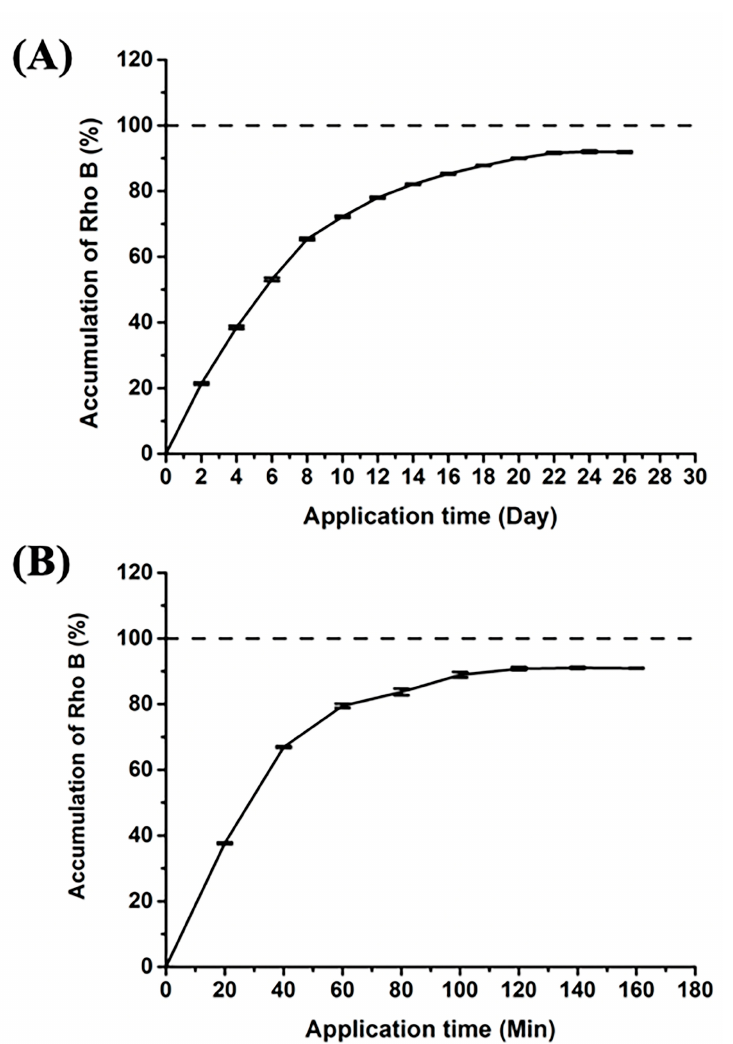
Figure 8. Release of Rho B from the HMP-DMN and control DMN patches. ( A ) Here, 90% of Rho B was released within 26 days. ( B ) Here, 90% of Rho B was released within 160 min. (Rho B: rhodamine B, HMP-DMN: heat-melt PLGA dissolving microneedle, DMN: dissolving microneedle).